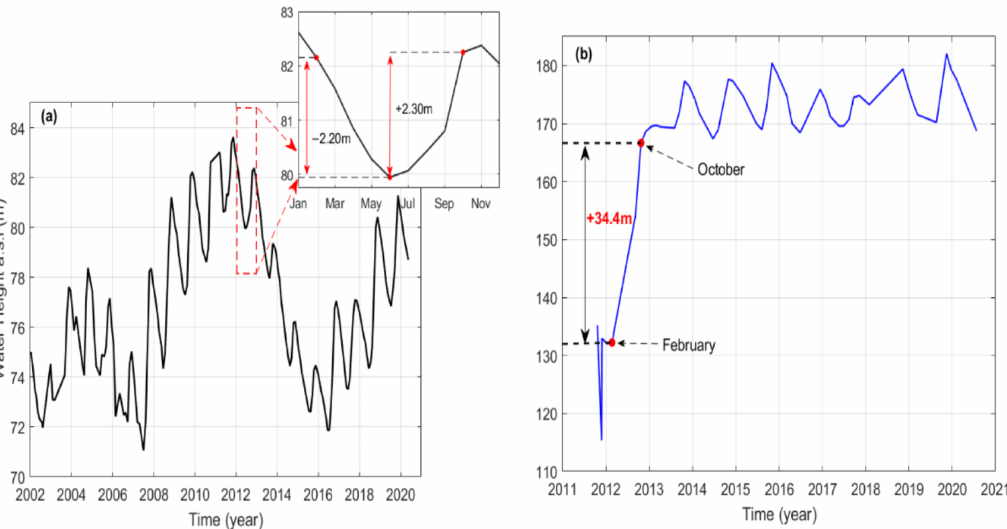
Figure 4. Radar altimetry-derived monthly water level records above sea level (a.s.l.) for ( a ) Lake Volta and ( b ) Bui reservoir. The dotted red box displays the inset of monthly water level time-series of the Lake Volta in